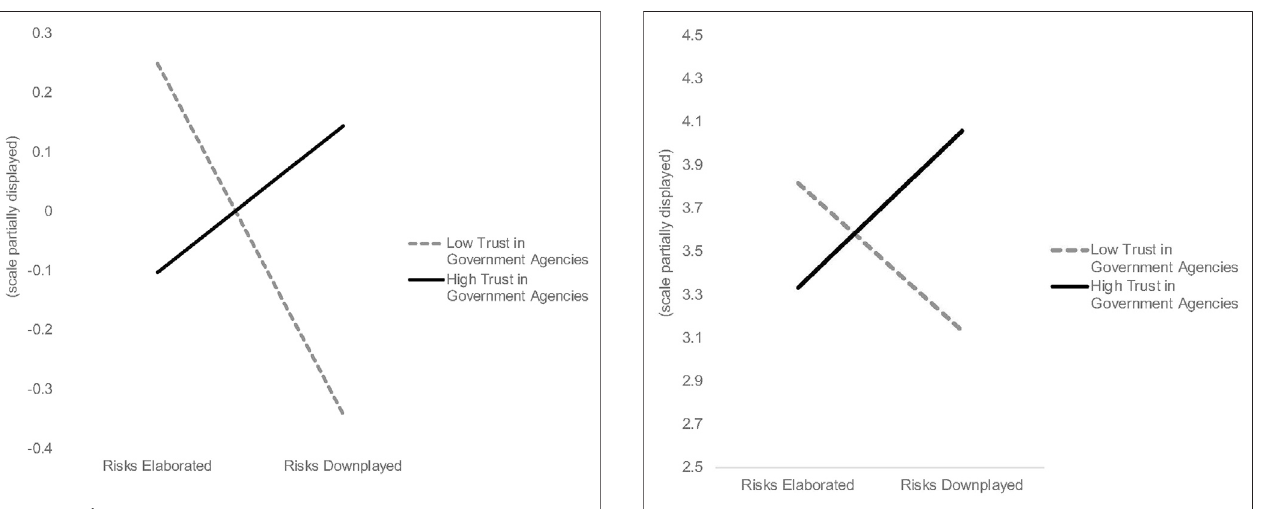
FIGURE 1 | Interaction effects of trust in government agencies and the experimental condition on anxiety levels. FIGURE 2 | Interaction effects of trust in government agencies and the experimental condition on risk